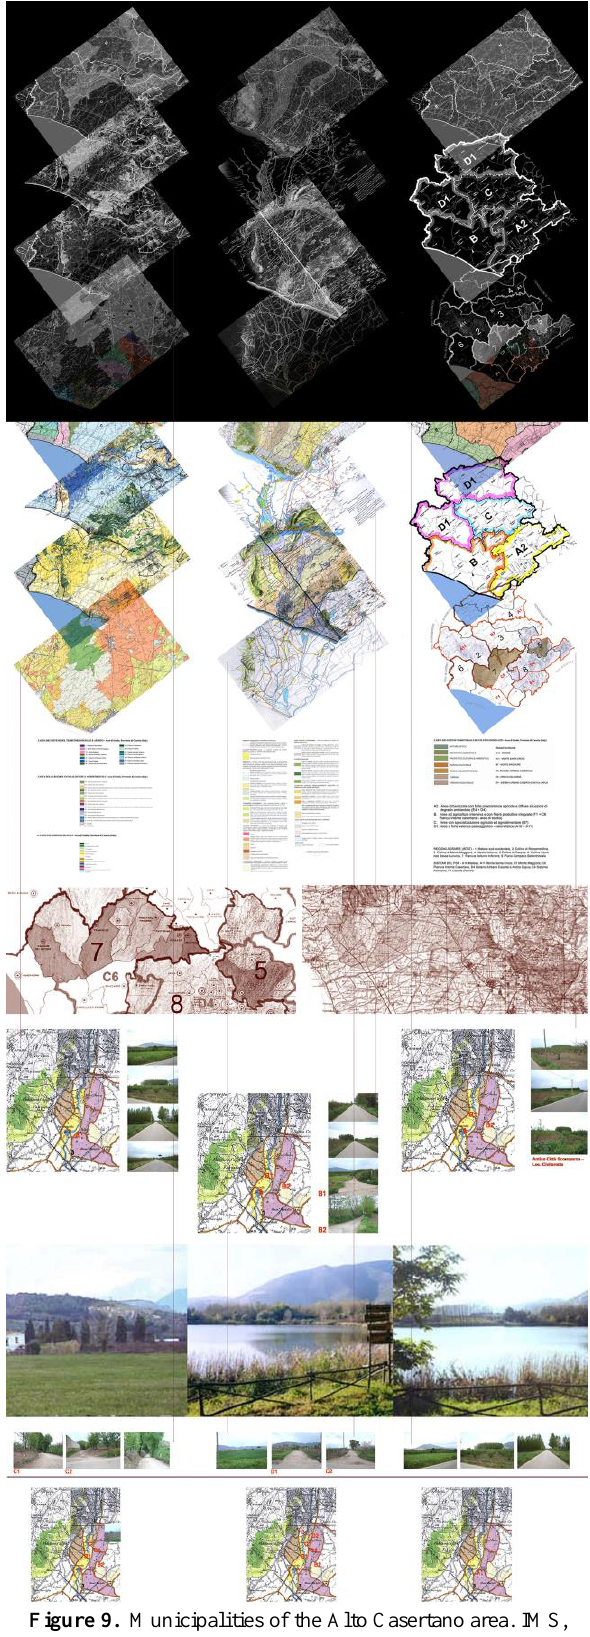
Figure 9. Municipalities of the Alto Casertano area. IMS, intersection between Landscape Apparatuses (Interpretative and Articulations classification) for the Strengthening of Cultural Identity and to promote Cultural - Tourist - Economic Development (A. De